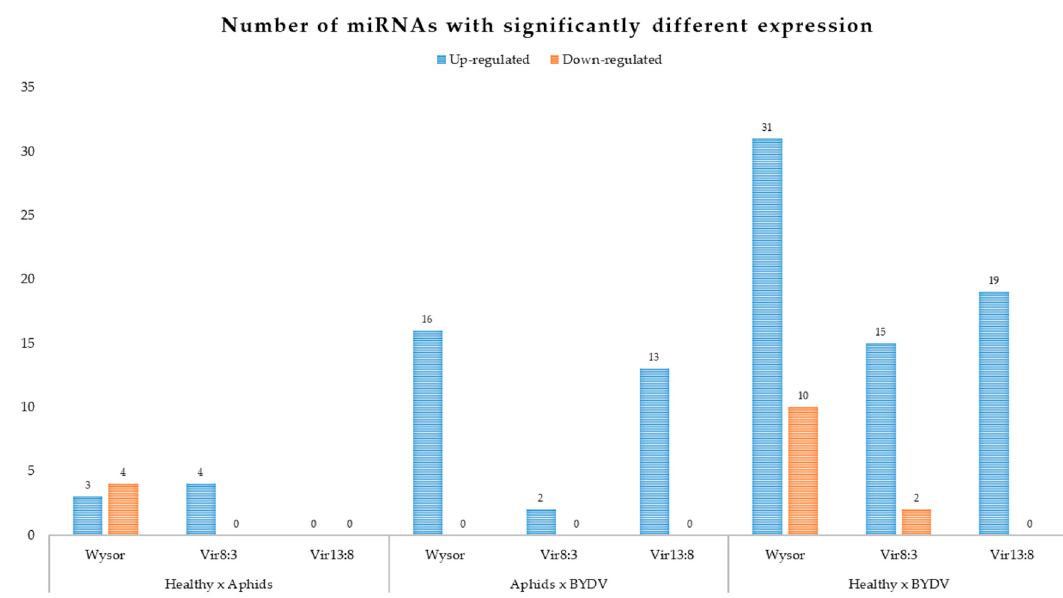
Figure 5. Number of differentially expressed miRNAs from barley cultivars Wysor, Vir8:3, and Vir13:8 in response to BYDV infection. The differential expression was analyzed using the R bioconductor packages DESEq2 and EdgeR. The miRNAs with a log fold-change (Log 2 FC) more than 1.5 (1.2) or less than Log 2 FC—1.5 (1.2) and with p -value less than 0.05 were considered significantly differentially expressed. Table 3. miRNAs with the greatest changes in expression after BYDV infection.